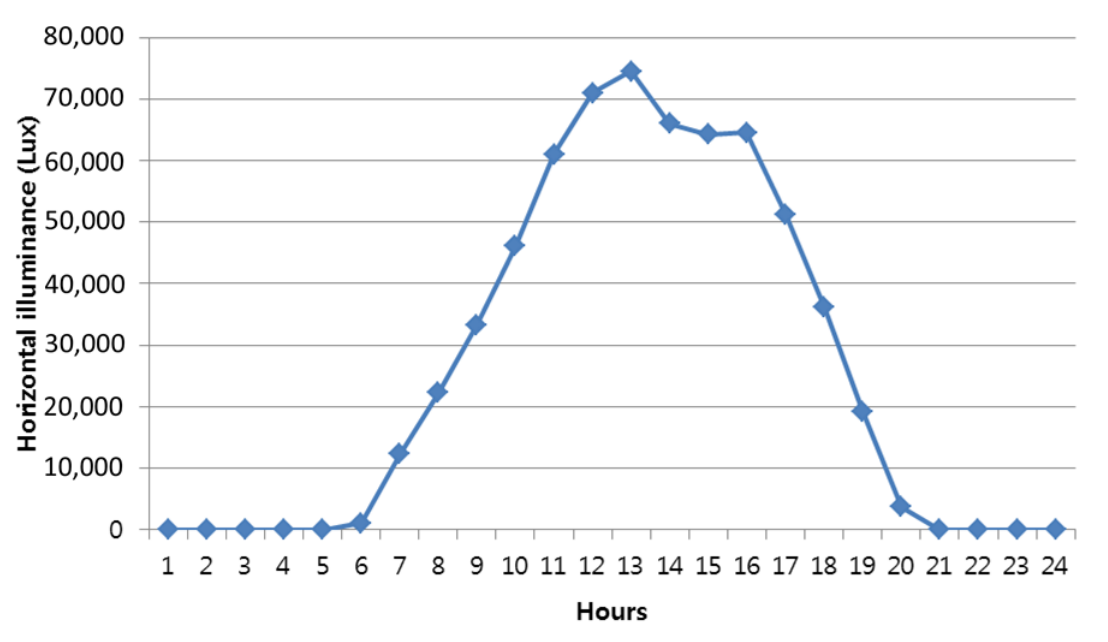
Figure 12. Hourly external horizontal